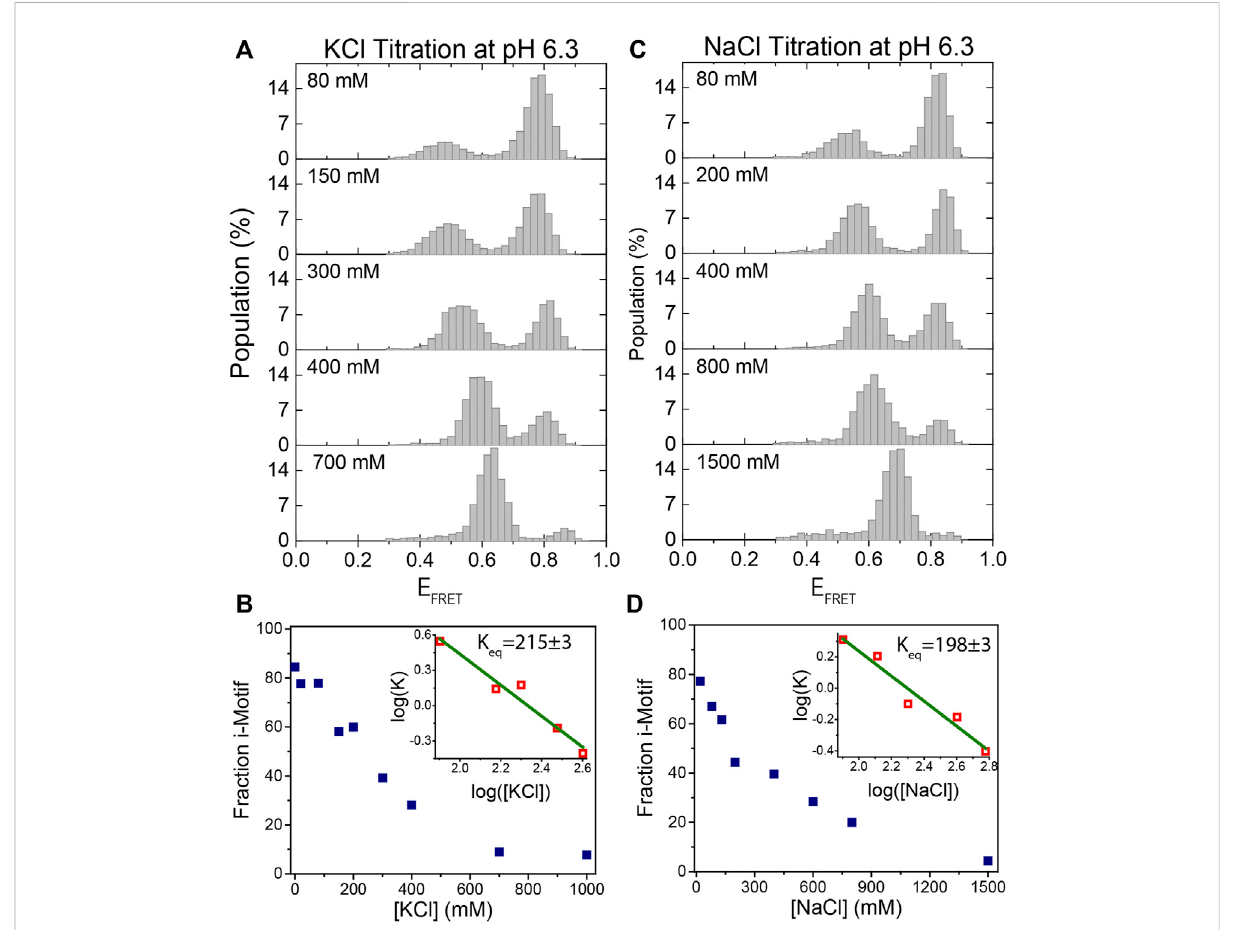
FIGURE 3 KClandNaCltitrationatpH6.3. (A) – (B) KCltitrationbetween0and1,000 mM. (C) – (D) NaCltitrationbetween0and1,500 mM.Themajorityof moleculesarefoldedatlowsaltconcentrationsandtheygraduallyunfold asthesaltconcentrationincreases.Theevolutionofthefractionofi-motif molecules as a function of (KCl) and (NaCl) are depicted in (B) and (D) respectively. Green lines in the inset are linear fi ts to the most rapidly varying segments of the curve of log ( K ) vs. log ( saltconcentration )